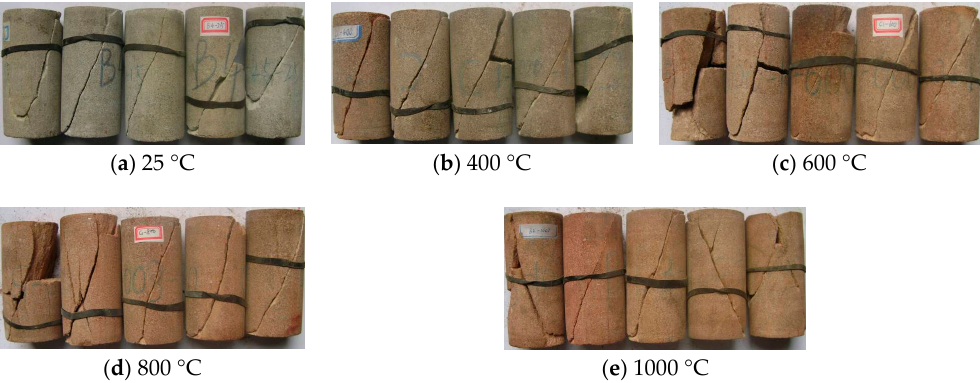
Figure 16. Rupture morphology of samples under conventional compression condition after high